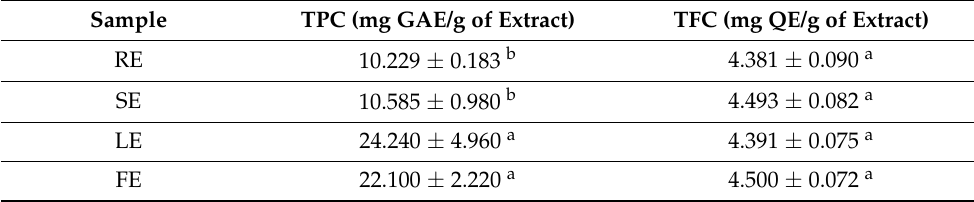
Table 2. Total polyphenol contents and total flavonoid contents in the P. rhoeas extracts.